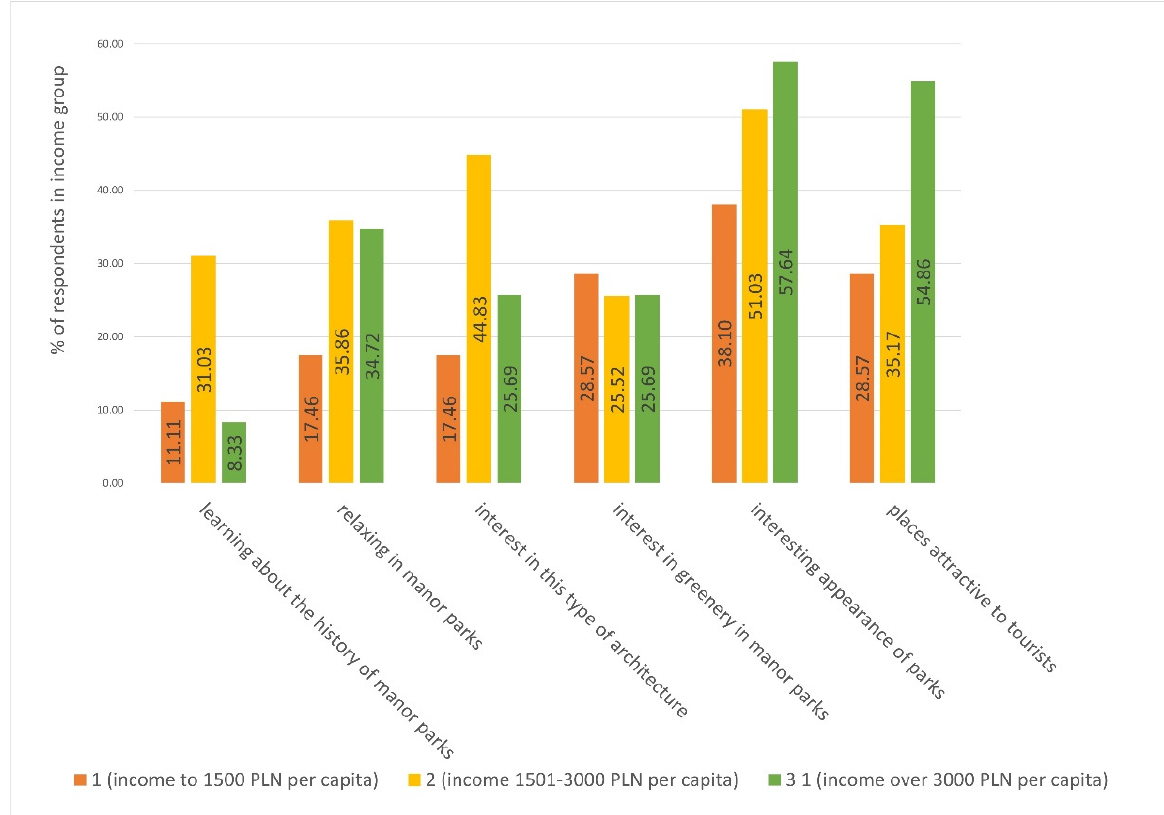
Figure 2. Comparison of the reasons for visiting manor parks based on per capita income.